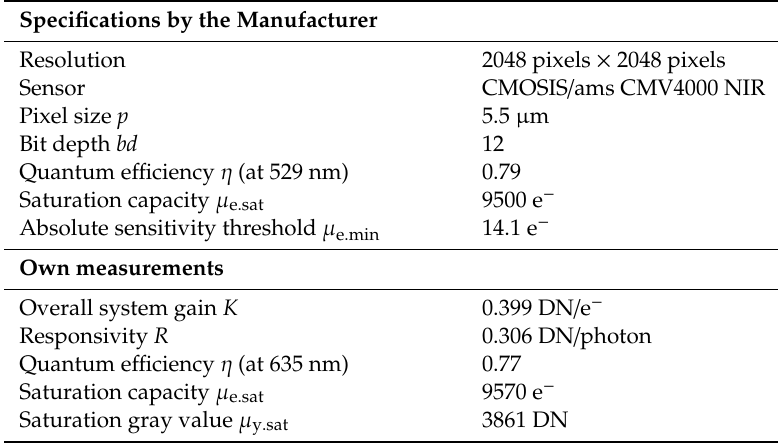
Table 2. Parameters of the camera Allied Vision Mako G-419B